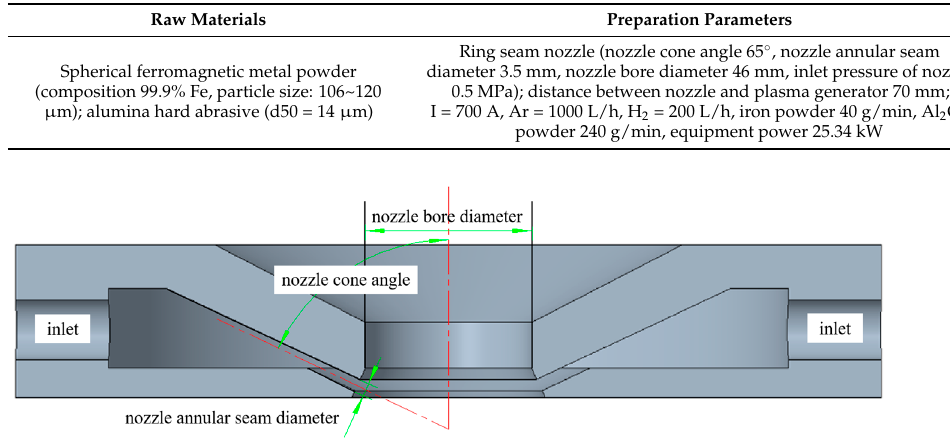
Figure 2. Spray tray structure parameters diagram.